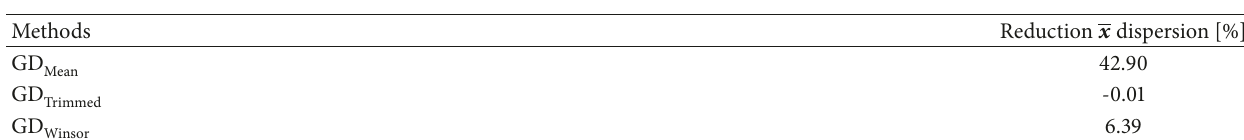
Table 71: G-h with 50